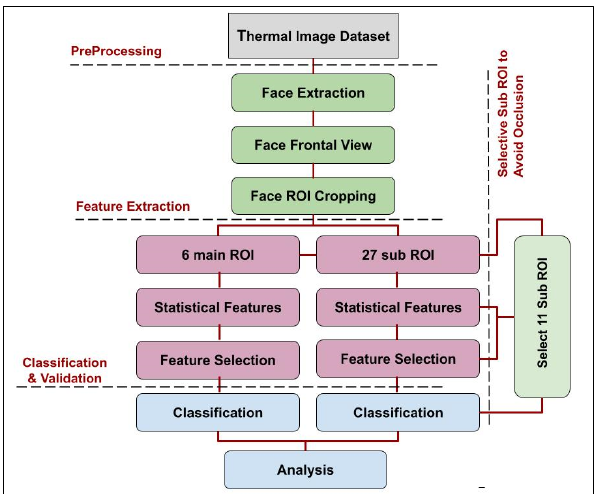
Figure 1. Stages of facial a ff ective state recognition using thermal images with occlusion.